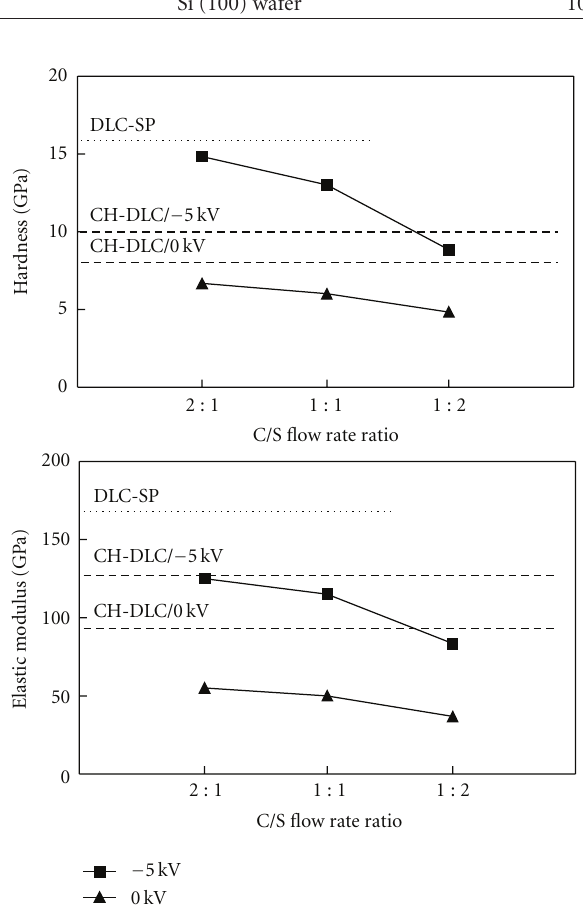
Figure 3: Nano indentation hardness and Elastic modulus values of CH-DLC films, DLC-SP film, and S-DLC